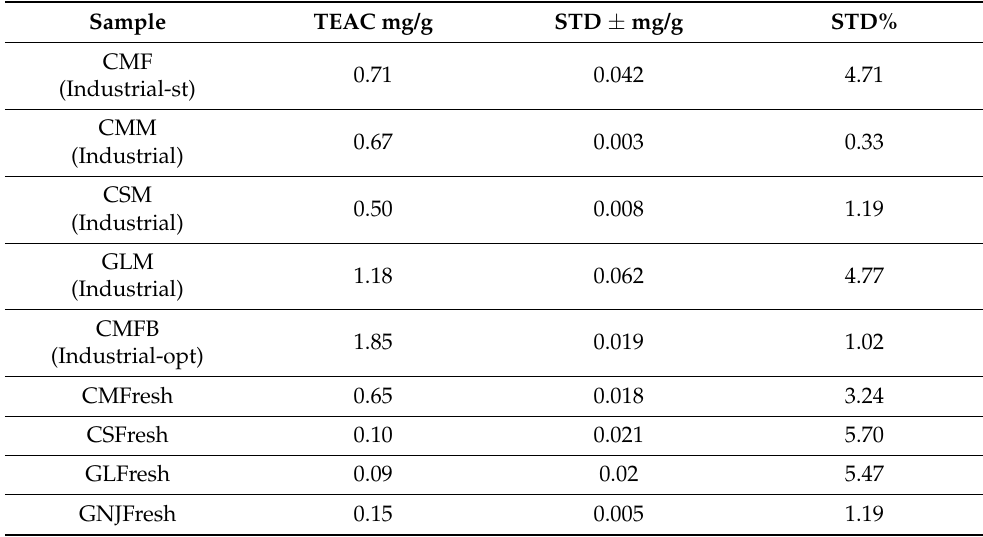
Table 6. Spectrophotometric assay for the determination of antioxidant activity in mushroom mycelium